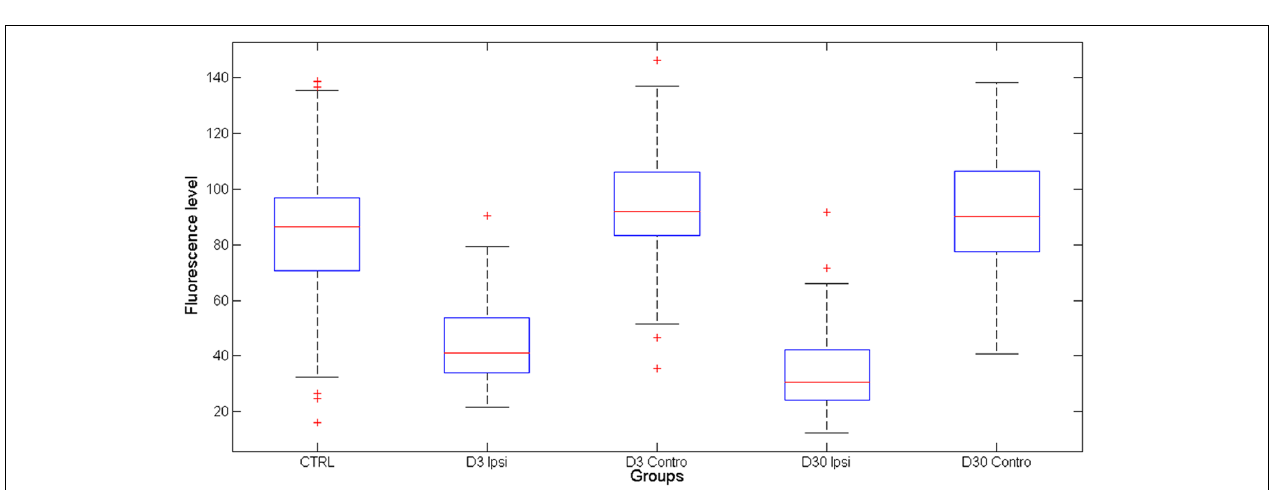
FIGURE 7 | KCC2-related fluorescence of cells bodies in control and lesioned animals from the region of interests delineated in Figure 6 (first and second column). The distribution of fluorescence levels from the region of interest drawn around the plasma membrane is shown in the third column (gray bars: left or ipsilateral to the lesion, blue bars: right or contralateral to the lesion).